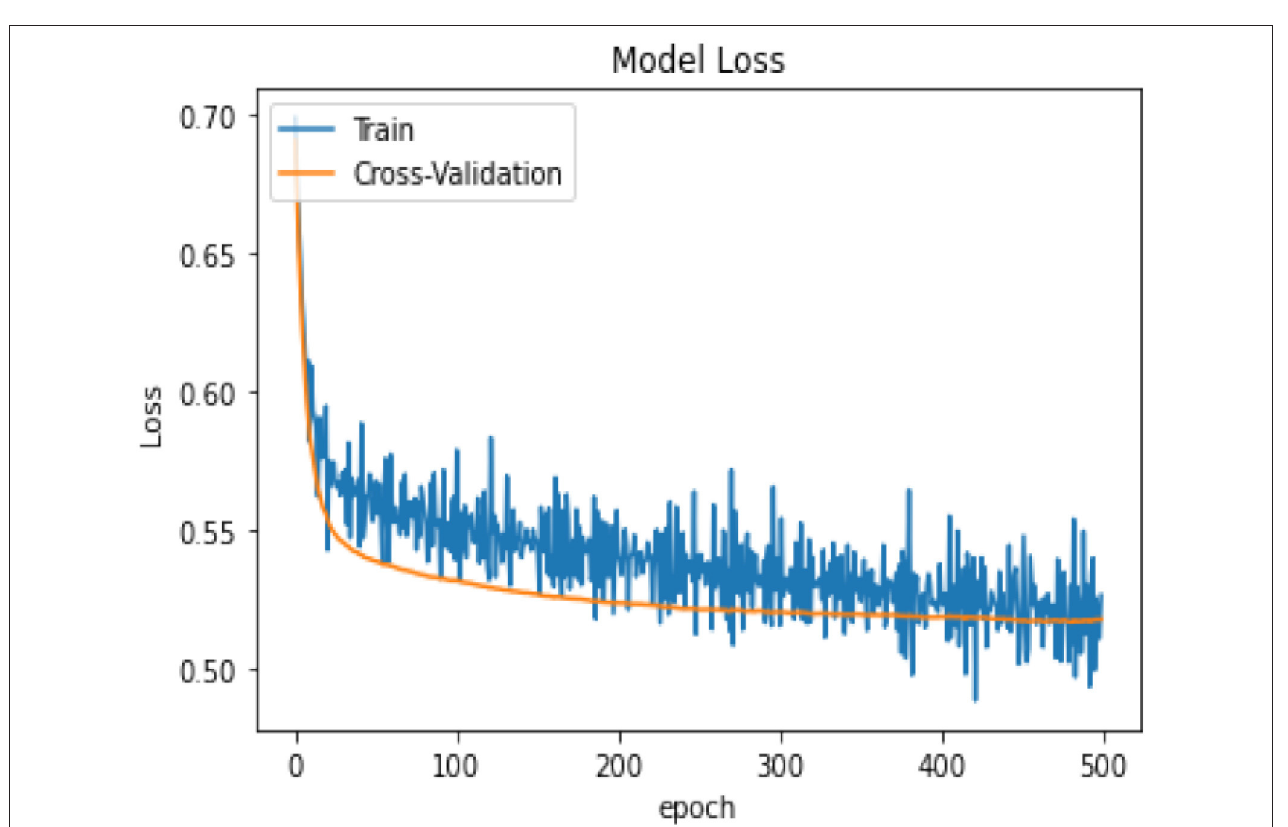
FIGURE 15 | ANN model loss-the